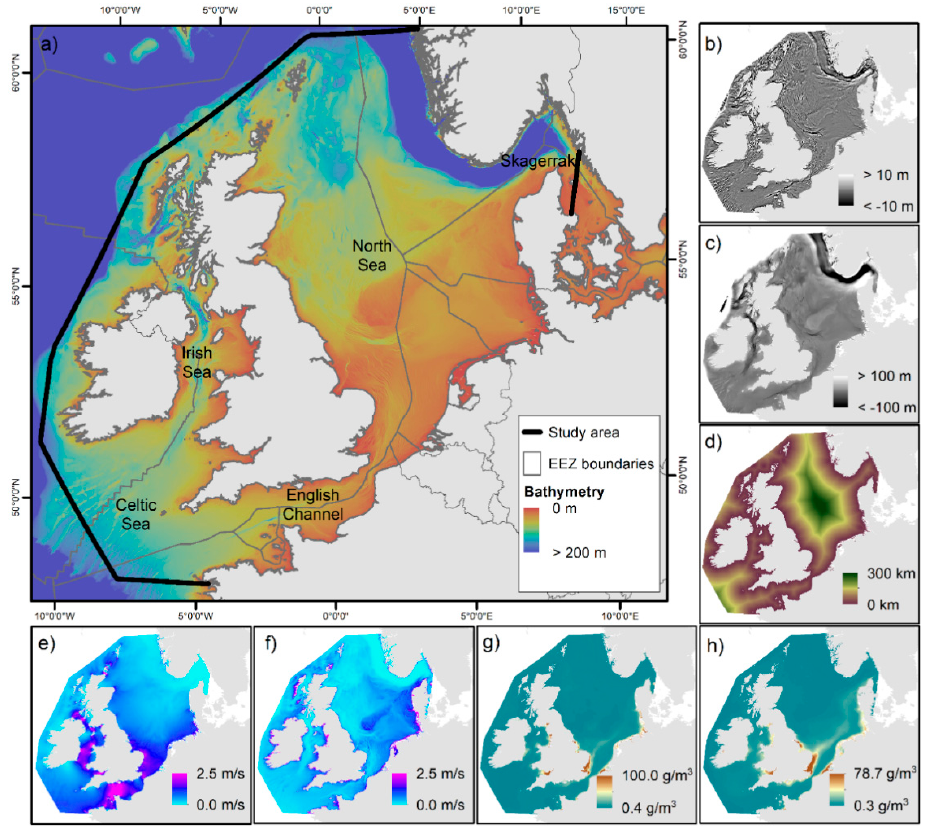
Figure 1. Study area and variables used to predict the distribution of seabed sediments. ( a ) Bathymetry. ( b ) BPI50 cells. ( c ) BPI434 cells. ( d ) Distance from coast. ( e ) Current speed. ( f ) Peak orbital velocity. ( g) Summer—suspended inorganic particulate matter. ( h ) Winter—suspended inorganic particulate matter. See Table 1 for additional details.